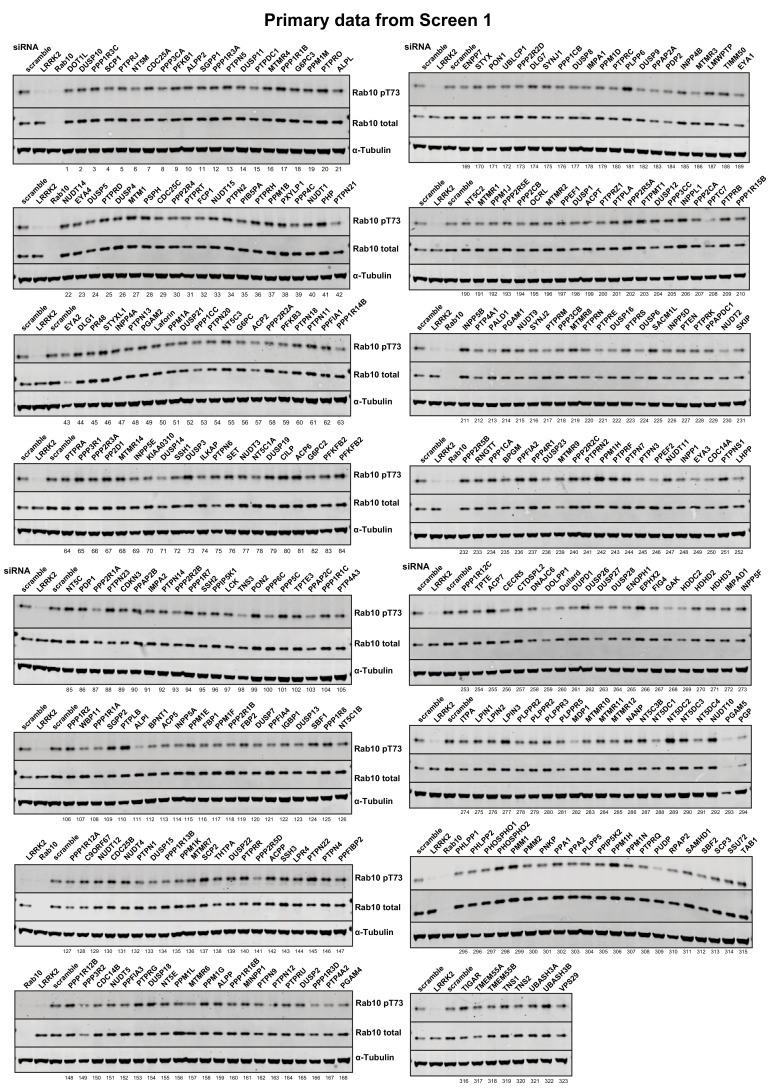
Primary data from siRNA Screen 1 Human A549 cells were transfected with the indicated siRNA pools (Dharmacon) for 72 hr.Cells were lysed and immunoblotted for the indicated antibodies and immunoblots developed using the LI-COR Odyssey CLx Western Blot imaging system. The numbering system corresponds to that employed in Supplementary file 1. The intensities were quantified and are presented as pRab10/Total Rab10 ratio relative to scrambled siRNA control in Supplementary file 1.